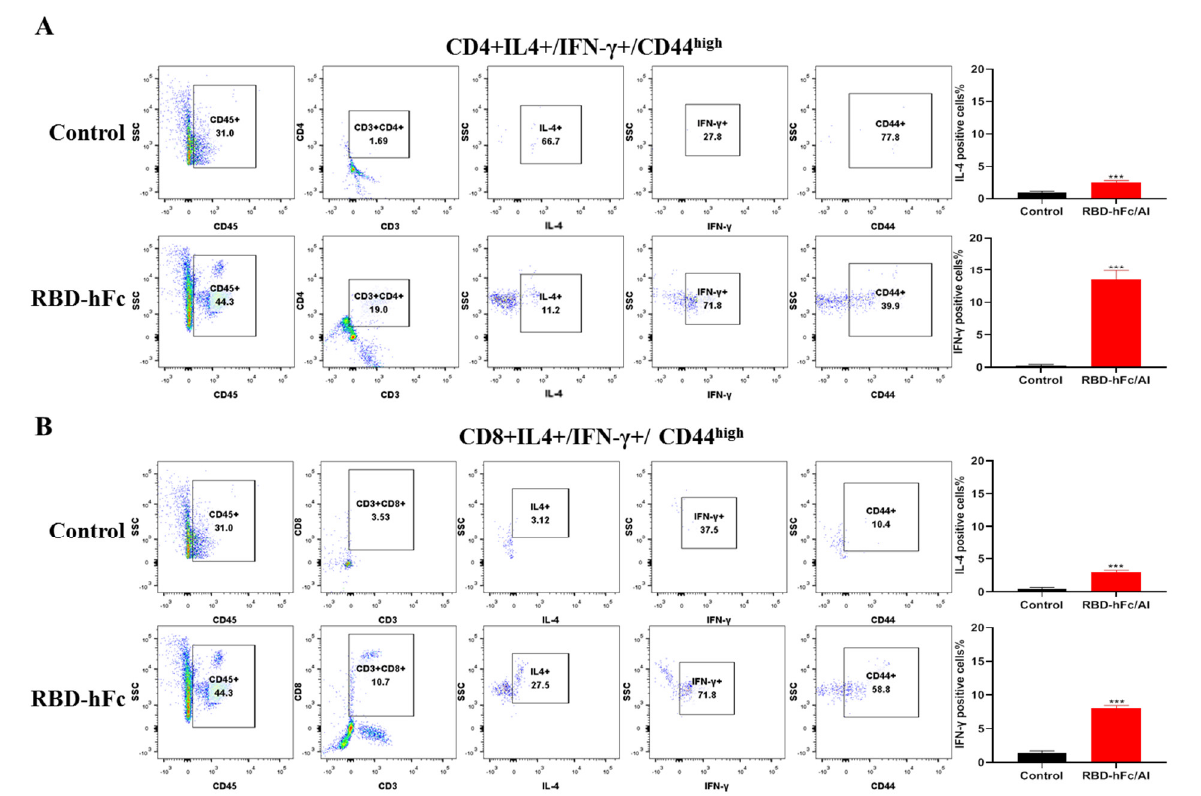
Figure 4. SARS-CoV-2 RBD-hFc vaccine induced a protective cell-mediated immune response in mice. The RBD-hFc fusion vaccine increases populations of memory CD4+ ( A ) and CD8+ ( B ) T cells. *** p < 0.001.